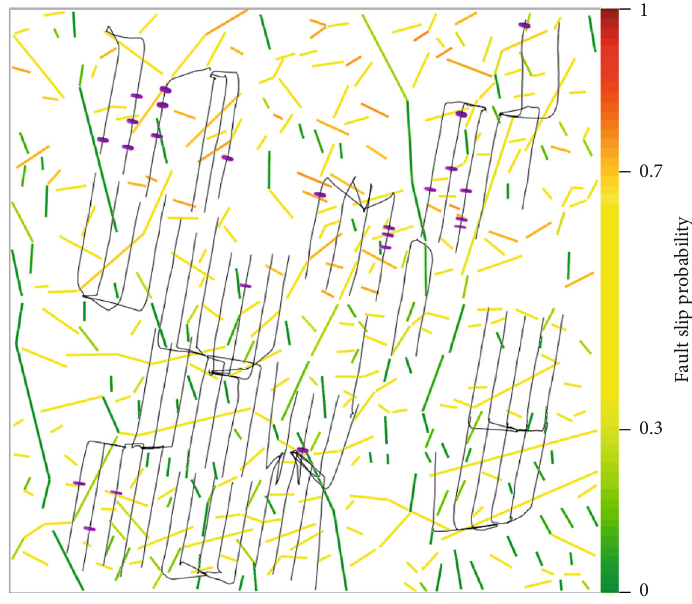
Figure 17: The slip probability of faults under typical hydraulic fracturing in the Ning209